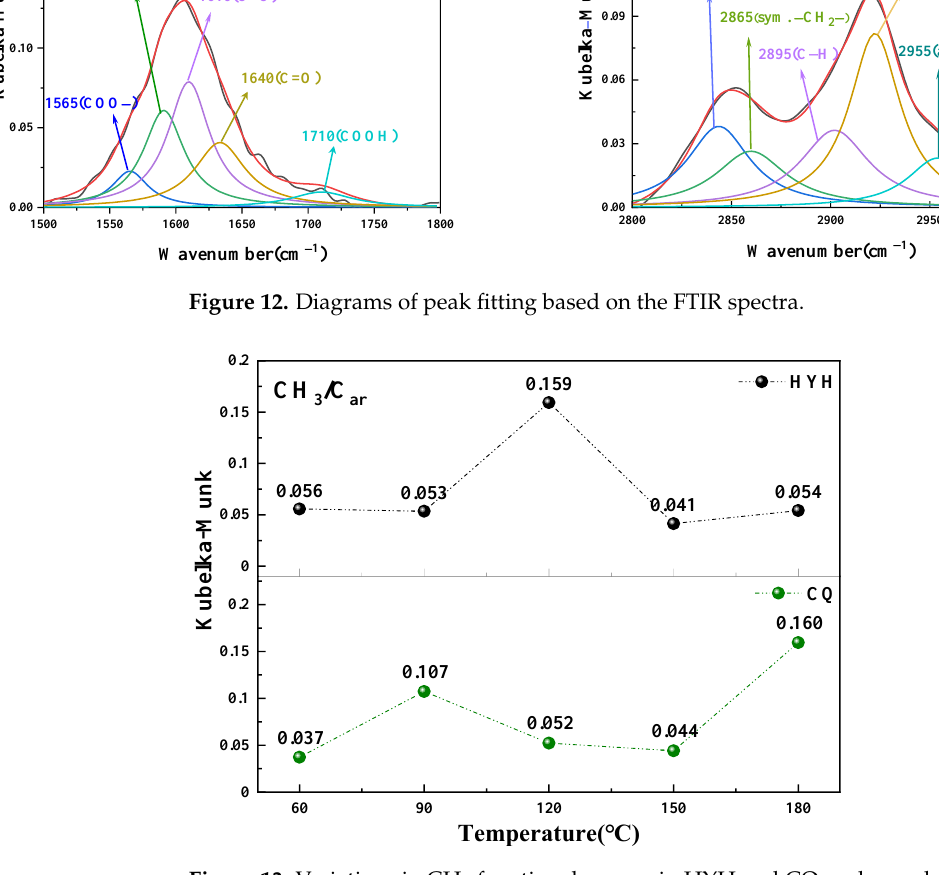
Figure 13. Variations in CH 3 functional groups in HYH and CQ coal samples.